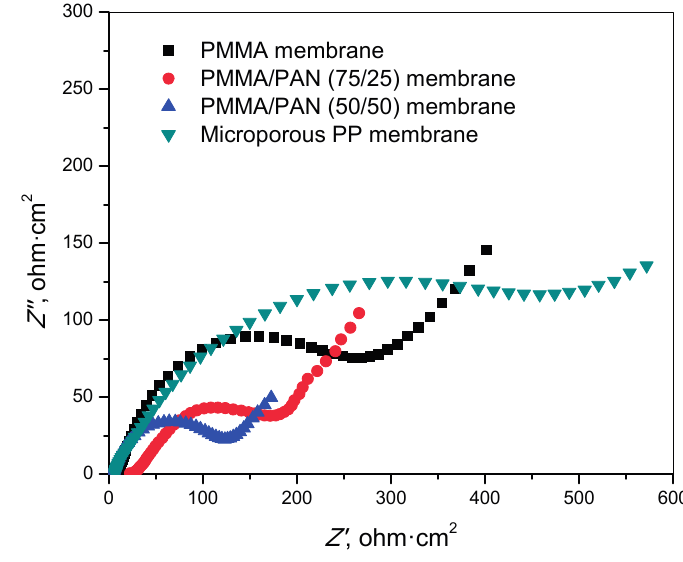
Figure 5. Electrochemical impedance spectra of Li/LiFePO 4 cells containing PMMA membrane, PMMA/PAN (75/25) membrane, PMMA/PAN (50/50) membrane, and microporous PP